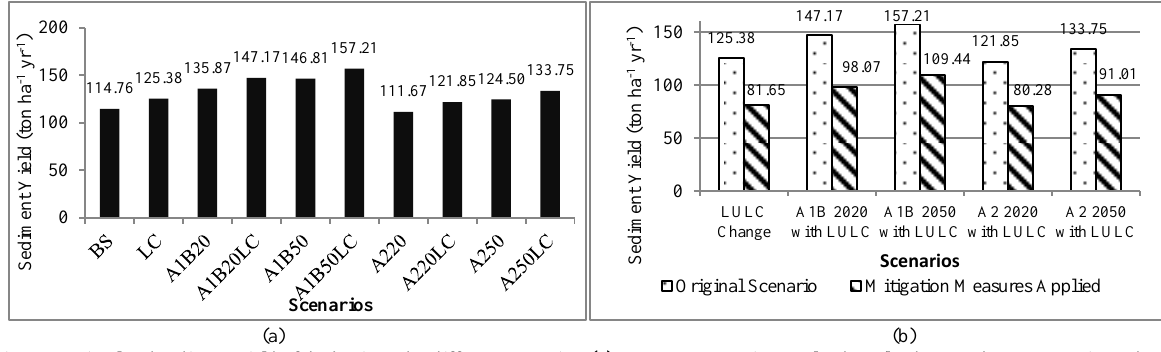
(b) Figure 6. Simulated sediment yield of the basin under different scenarios: (a) BS=Base Scenario, LC=land use/land cover change scenario, codes for other scenarios: A1B=climate change scenario A1B, A2= climate change scenario A2, 20=corresponds to year 2020, 50=corresponds to year 2050 (e.g., A1B20LC= climate change scenario A1B at year 2020 with land use/land cover change scenario); (b) Comparison of sediment yields generated before and after applying mitigation measures.